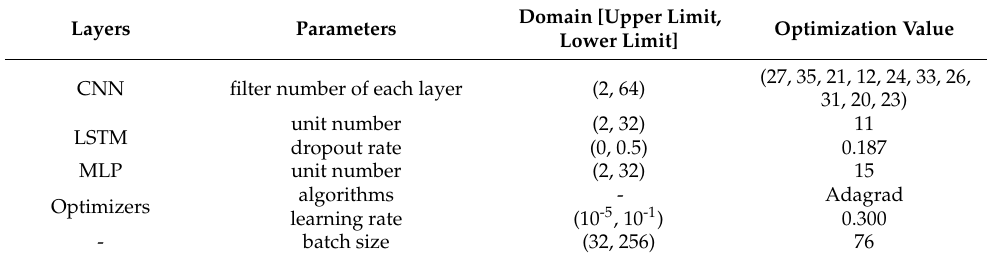
Table A2. The hyperparameters of the proposed model (vertical